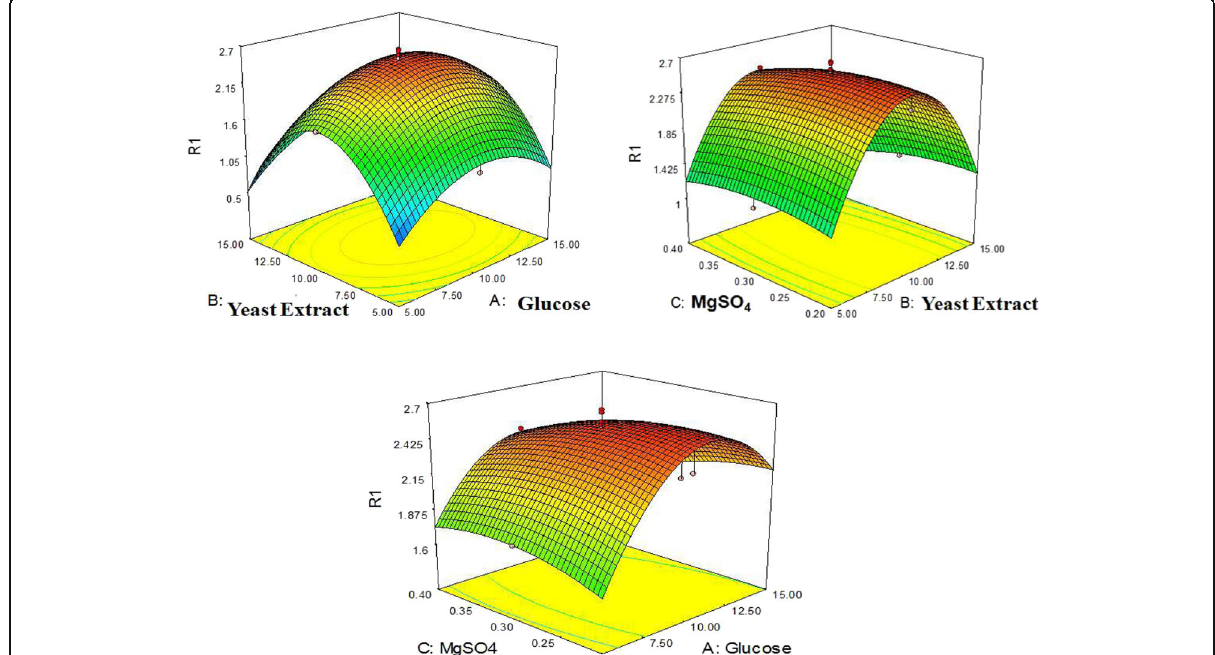
Fig. 8 3D graphs showing the combinational interaction of variables on production of